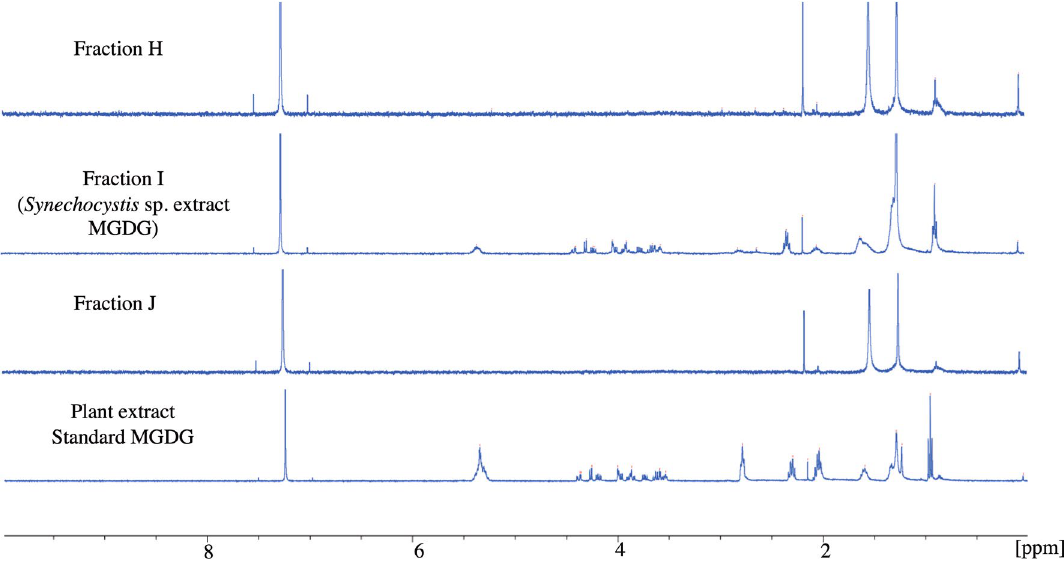
Figure 3. Confirmation of the presence of MGDG extracted from Synechocystis sp. PCC 6803 in fraction I. 1 H NMR analysis of Synechocystis sp. extracted fractions H, I, and J with 40% chloroform and 60% acetone eluent combination. The NMR spectra of the MGDG standard are shown in the lowest panel. The NMR analysis confirms the presence of MGDG molecule in fraction